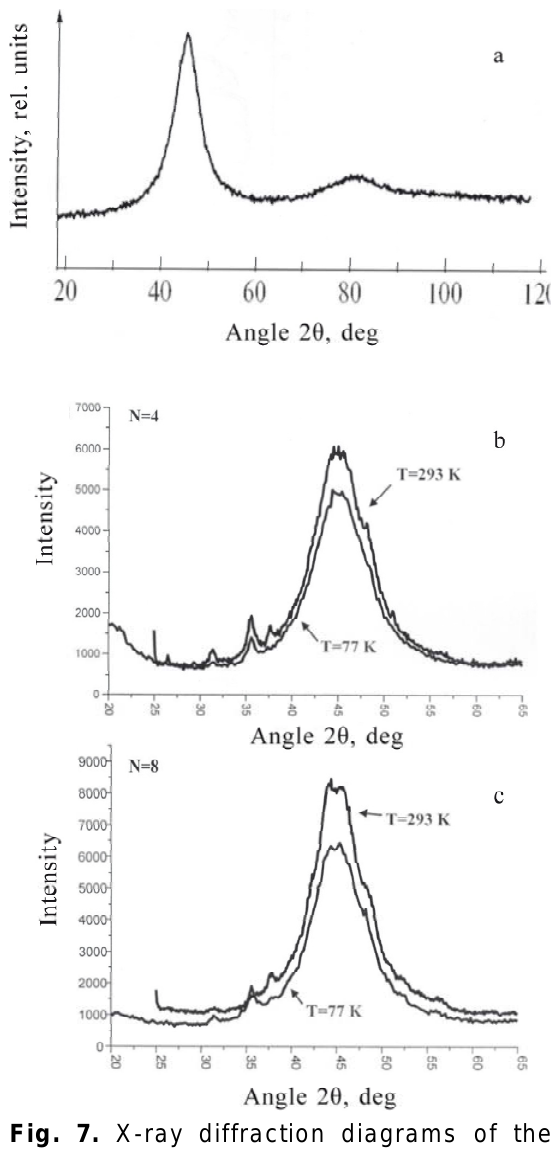
Fe Co Si B 44 29 15 2 10